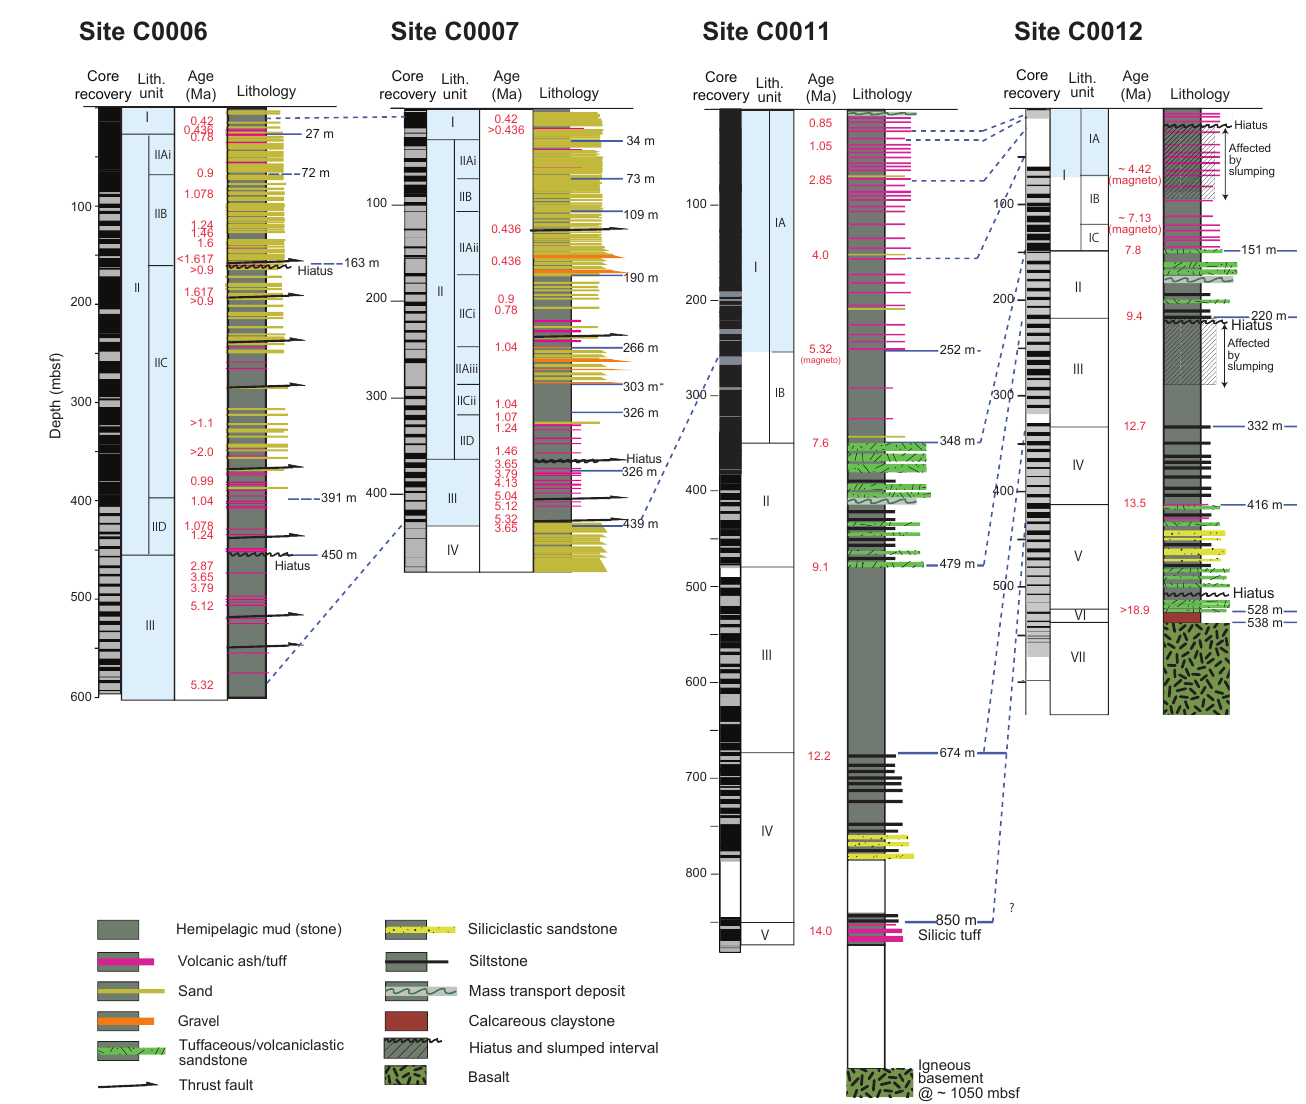
Figure 3. Lithological section across the Nankai frontal prism (Sites C0006 and C0007) and the input sites (C0011 and C0012). The columns at each site show core recovery, lithologic units, sedimentary age, and lithology distribution modified from Kinoshita et al. (2009), Strasser et al. (2014), and references